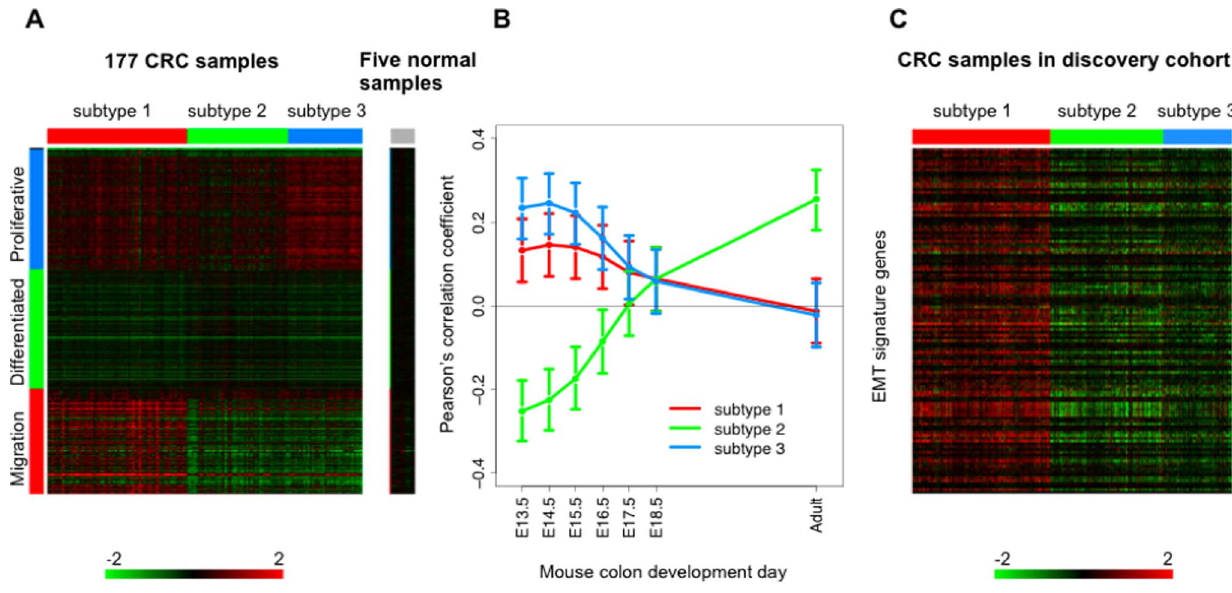
Figure 3. Unique cancer biology in three CRC subtypes. (A) Expression of signature genes in three CRC subtypes compared to expression in normal samples. The heat map was based on 1472 selected genes, and the gene expression dataset GSE17536 with 177 human CRC samples and five normal mucosal samples. (B) The correlation between the gene expression pattern of three CRC subtypes and the expression pattern of different stages of mouse colon development based on time related genes. The time series are indicated on the horizontal axis, while Pearson correlation coefficients are indicated on the vertical axis (Points represent Pearson correlation coefficients, bars represent 95% confidence intervals). (C) The expression of EMT signature genes in three CRC subtypes.